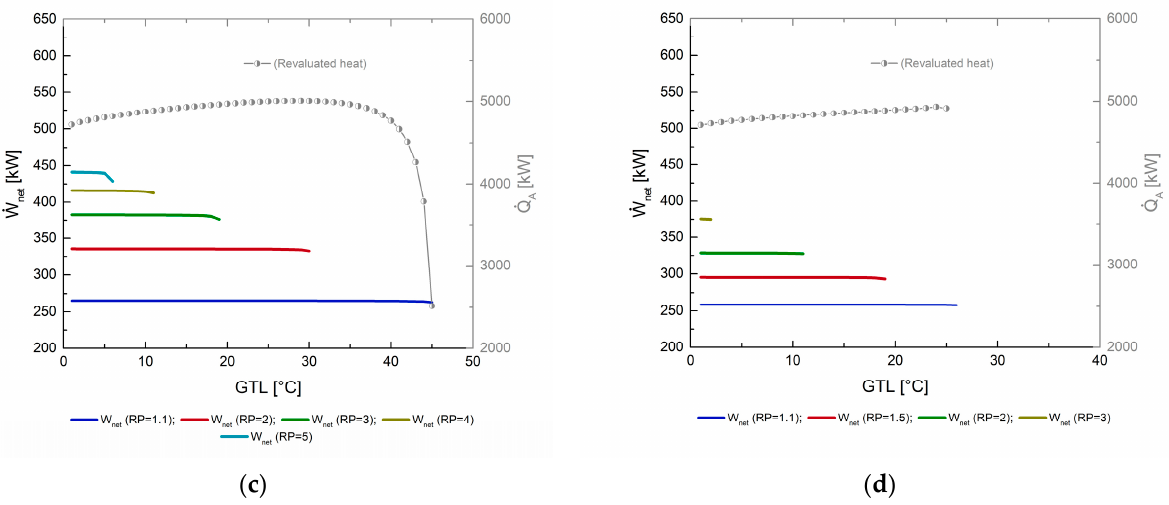
. . Figure 4. Net power ( W(cid:4662) (cid:2924)(cid:2915)(cid:2930) ) and revaluated heat ( Q(cid:4662) (cid:2885) ) as a function of GTL. ( a ) T GH = 160 °C; ( b ) T GH Figure 4. Net power ( W net ) and revaluated heat ( Q A ) as a function of GTL. ( a ) T GH = 160 ◦ C; = 140 °C; ( c ) T GH = 120 °C; ( d ) T GH = 100 °C. ( b ) T GH = 140 ◦ C; ( c ) T GH = 120 ◦ C; ( d ) T GH = 100 ◦